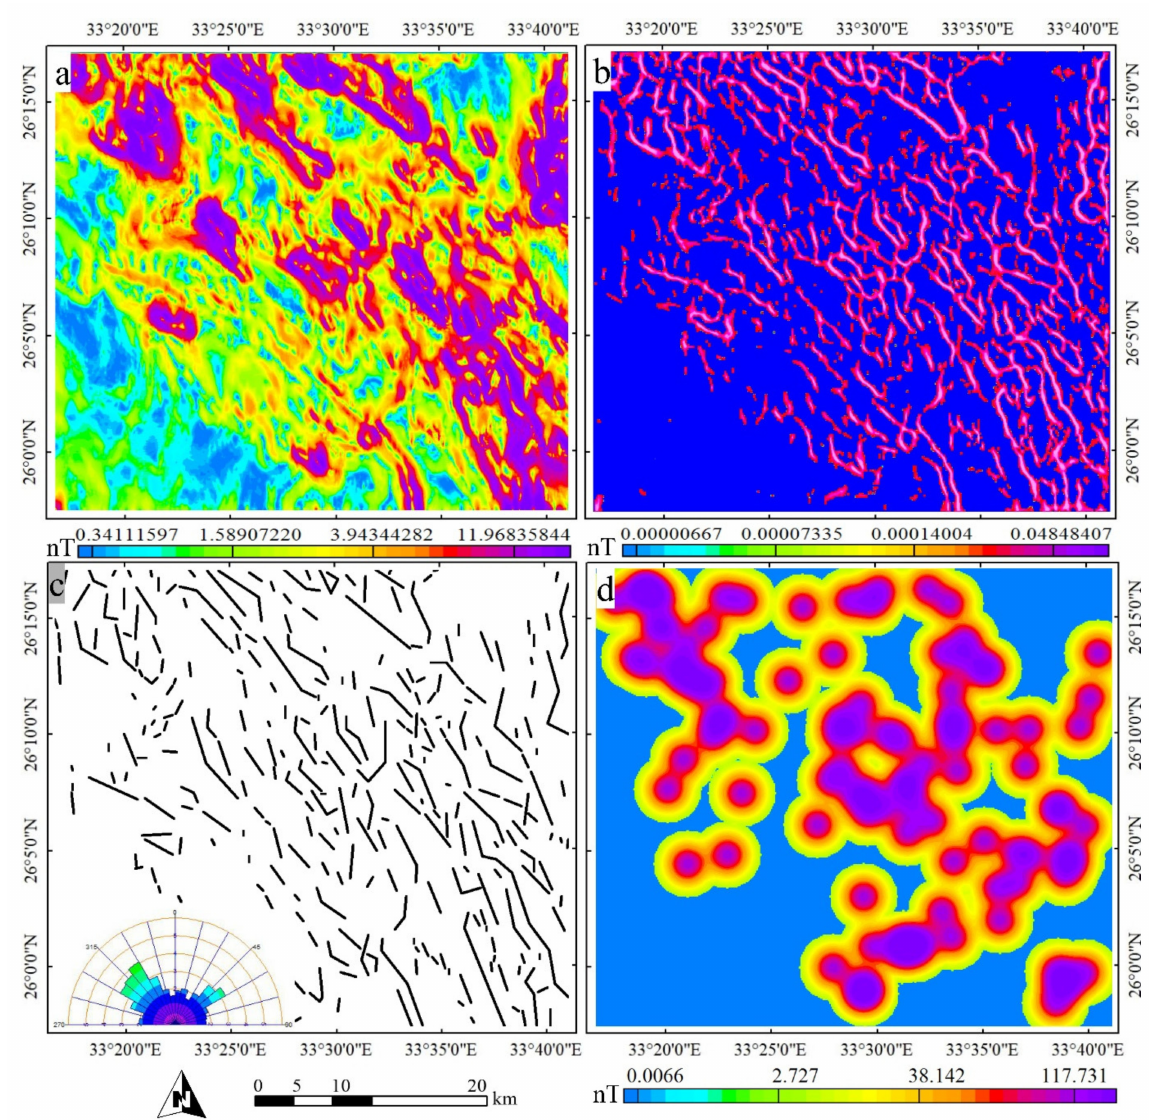
Figure 4. CET results: ( a ) standard deviation, ( b ) phase symmetry, ( c ) generated automated lineaments, and ( d ) entropy heat